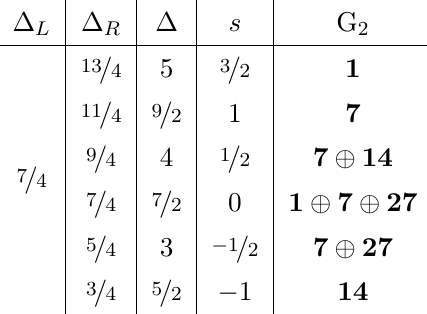
= (7 ; 0) supersymmetry. The gauge group N